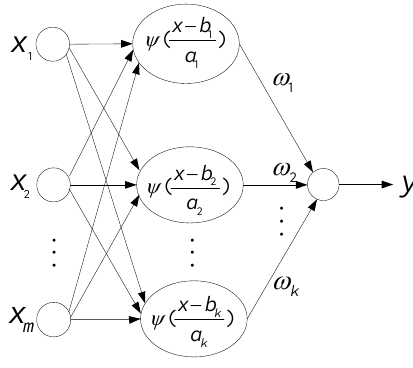
Figure 1. Three layer WNN